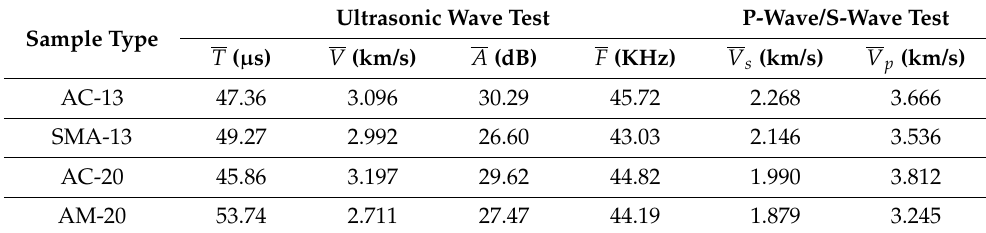
Table 5. Averaged acoustic properties in two